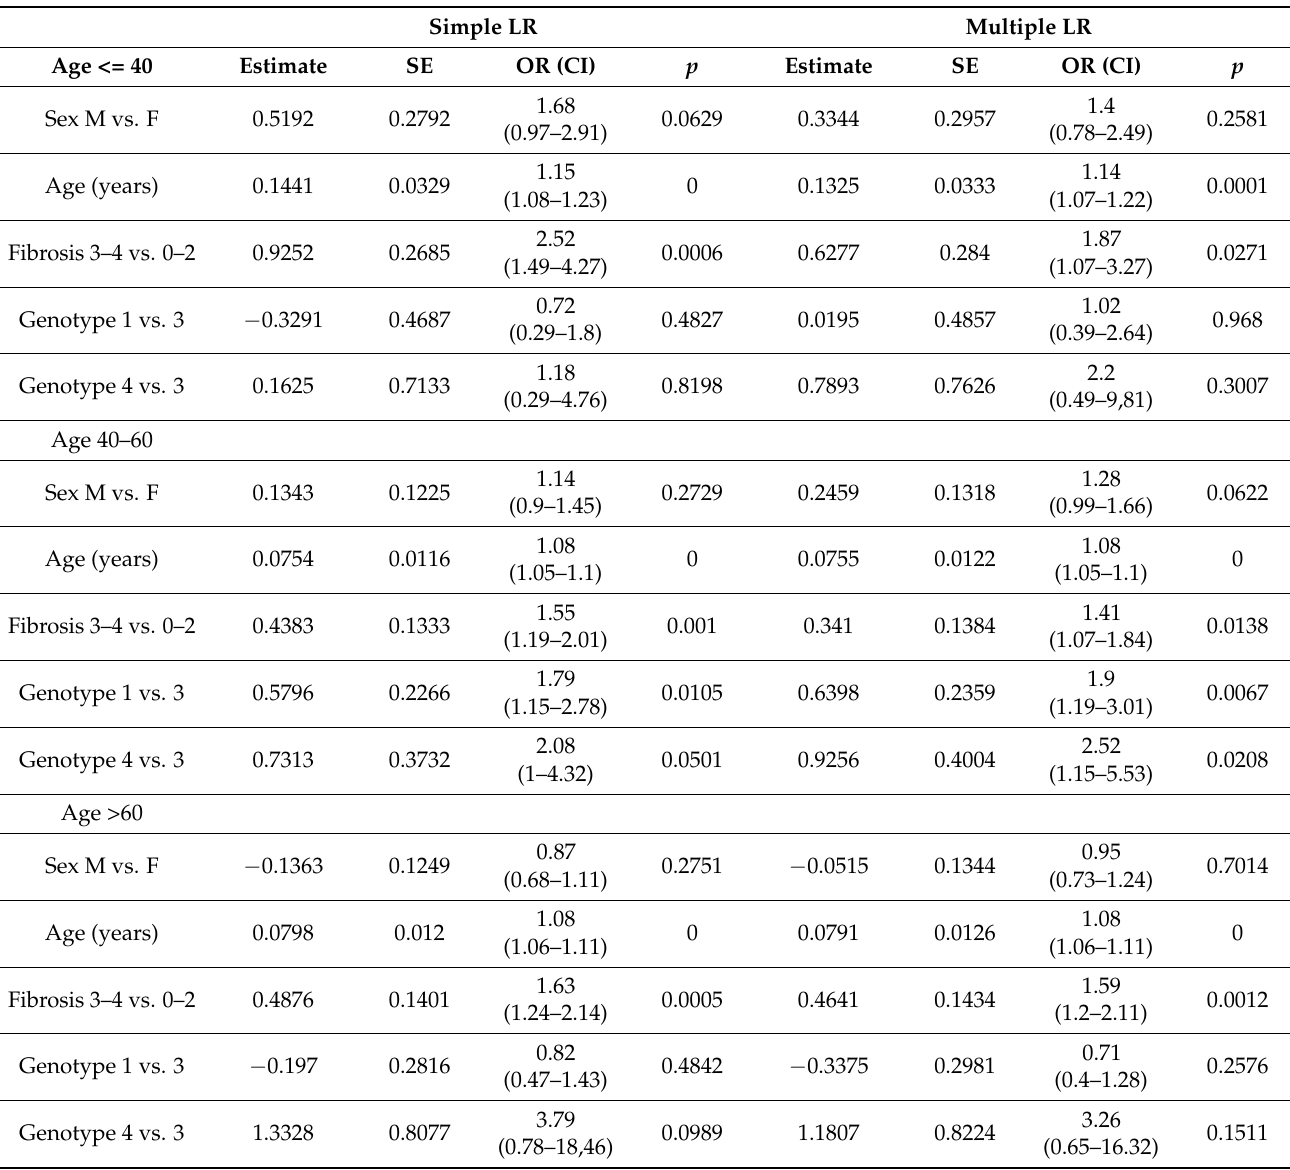
Table 7. Logistic regression in the analyzed age